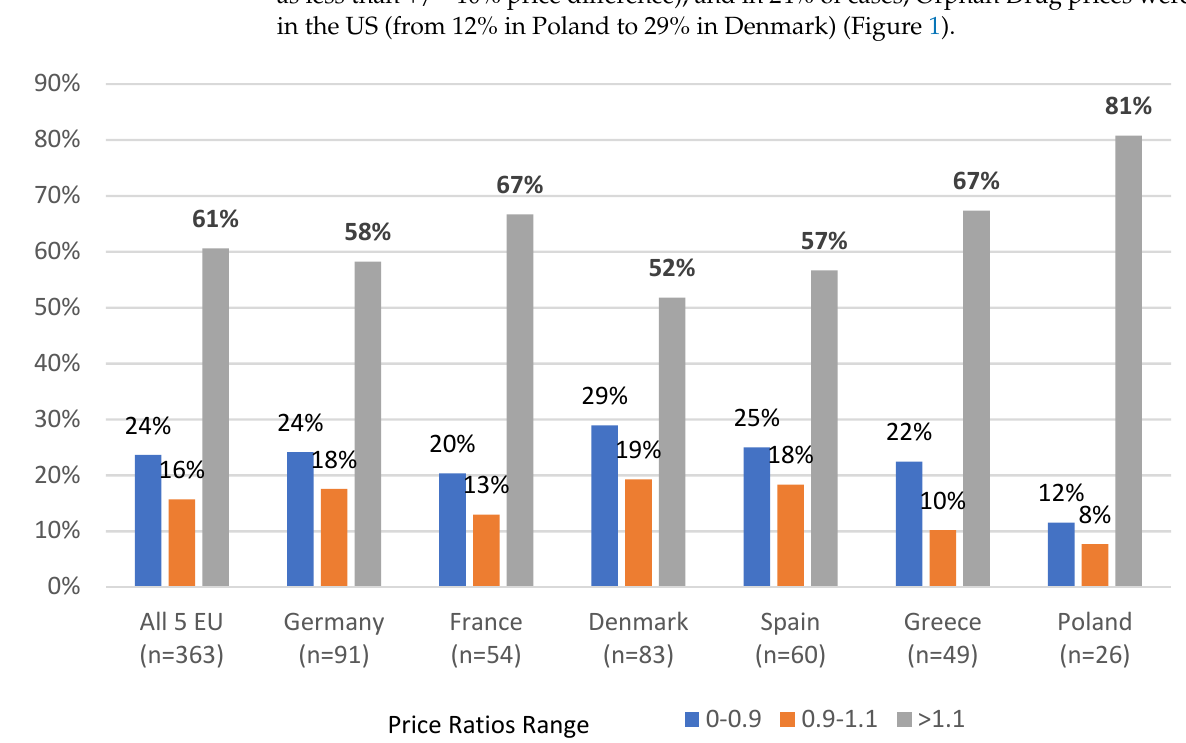
Figure 2. Orphan Drugs Average Price Ratios—segmented by the date of the first FDA approval. Comparison of US vs. six EU Countries (Denmark, France, Germany, Greece, Spain, Poland). 3.2. EU Individual Country vs. EU Average EU cross-country price comparisons of Orphan Drugs indicated much more homogenous pricing across all analyzed EU countries. Average Price Ratios calculated for each of the analyzed EU countries were in the range from 0.9 for France to 1.07 for